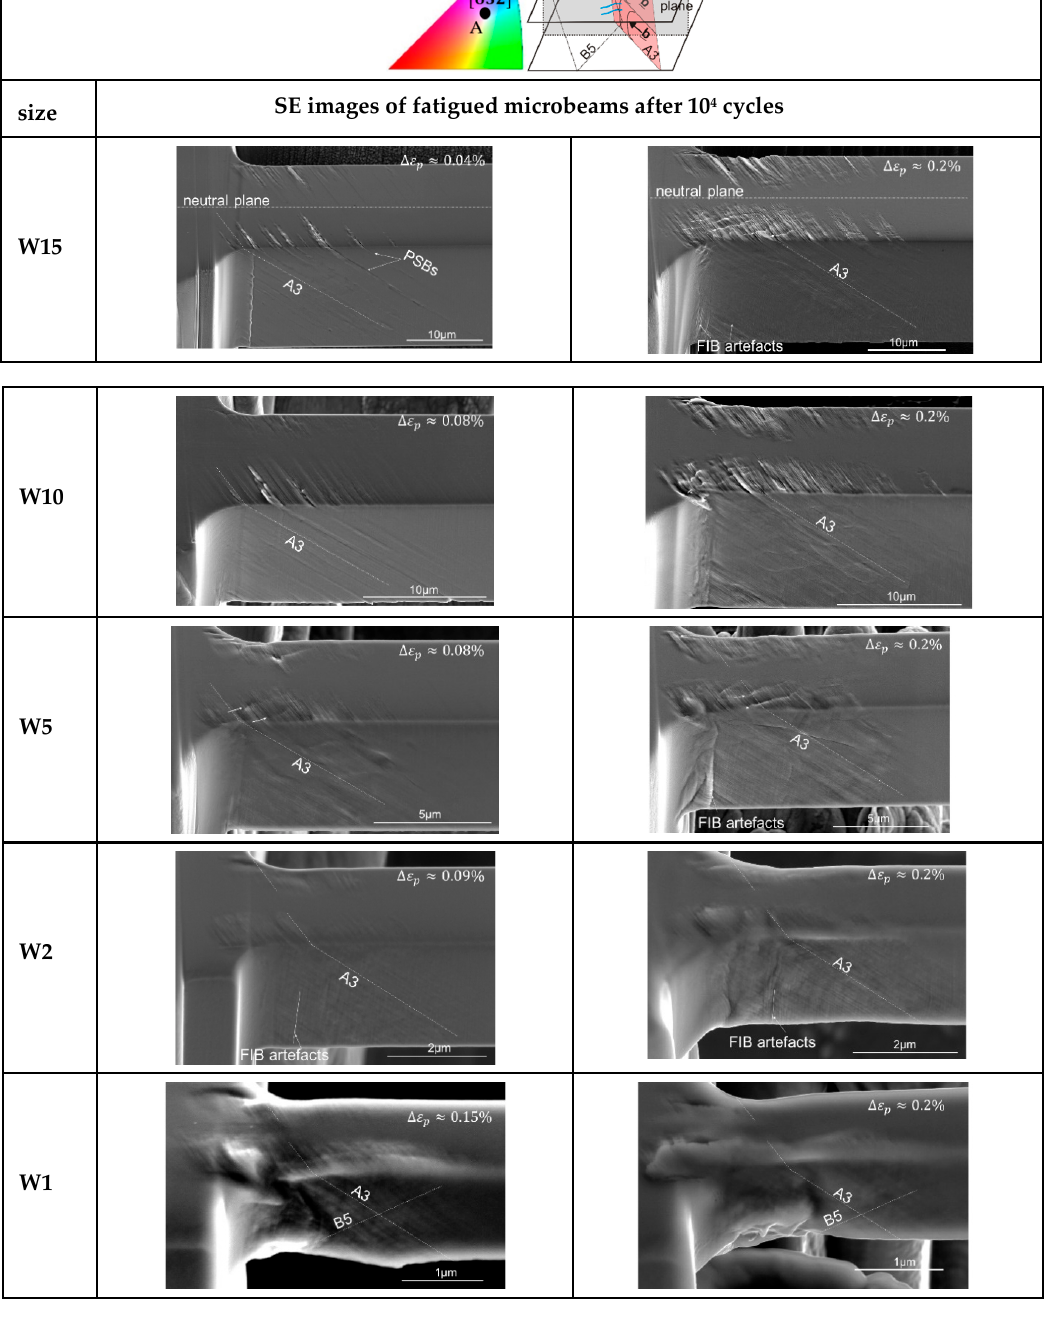
Figure 4. Evolution of the surface roughness of microbeams oriented for single slip with different sizes (from 15 to 1 µm (W15 to W1)). Left column: Small strain amplitude and right column: Larger strain amplitude ∆ ε p (see values on the respective beams). Orientation and the sketched glide systems A3 and B5 with the largest Schmid factor are on the first row for more clarity.